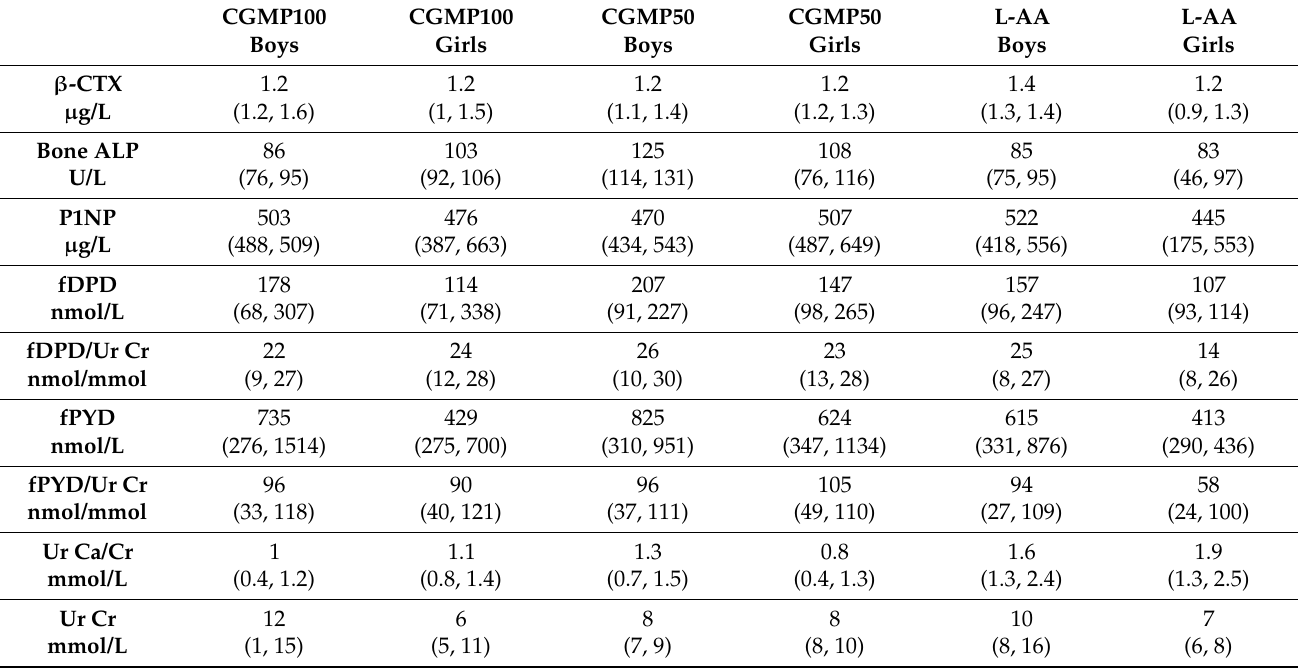
Table 5. Median (range) serum bone and urine turnover markers calculated from enrolment, 12, 24, and 36 months for CGMP100, CGMP50 and L-AA groups in girls and boys.